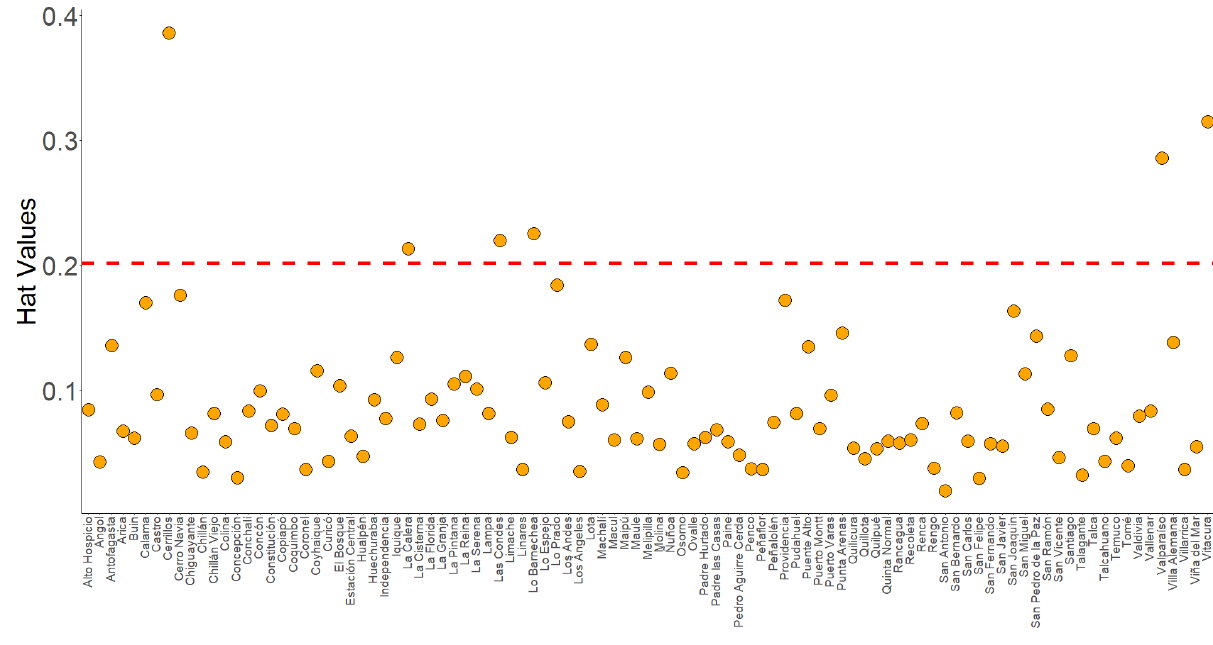
Figure 8. Hat values for each council on response